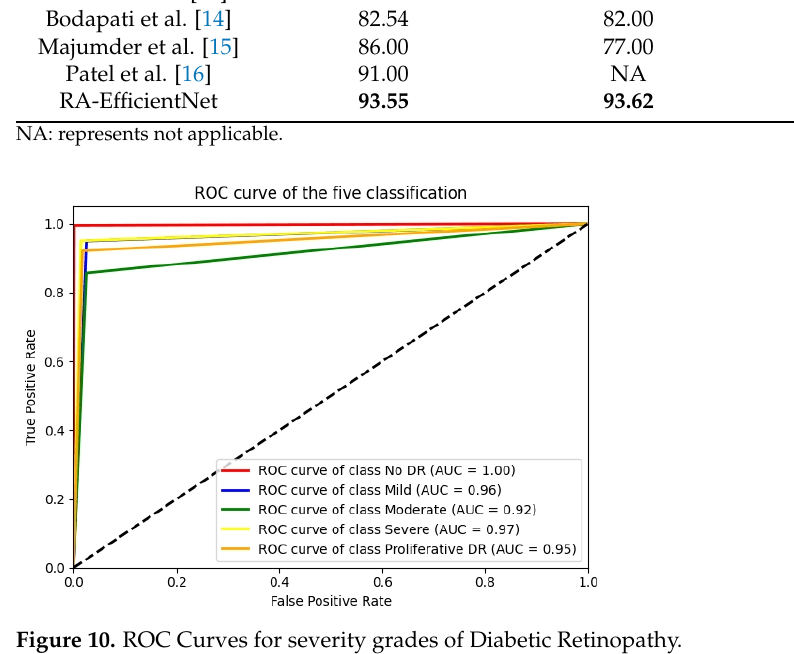
Figure 10. ROC Curves for severity grades of Diabetic Retinopathy.